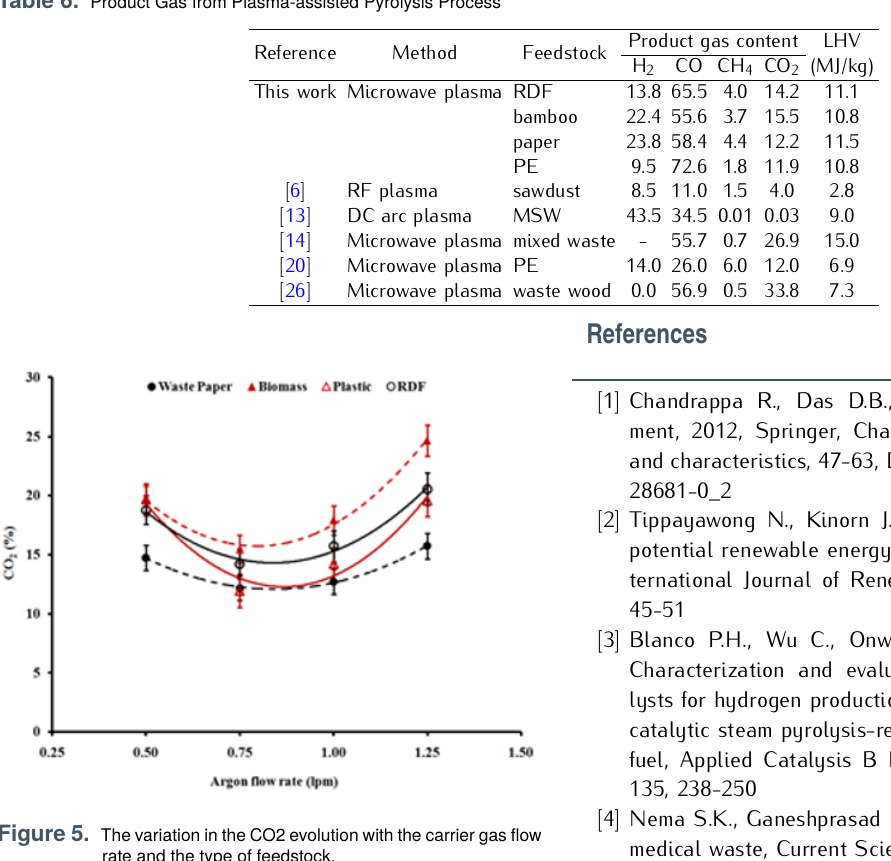
Table 6. Product Gas from Plasma-assisted Pyrolysis Process